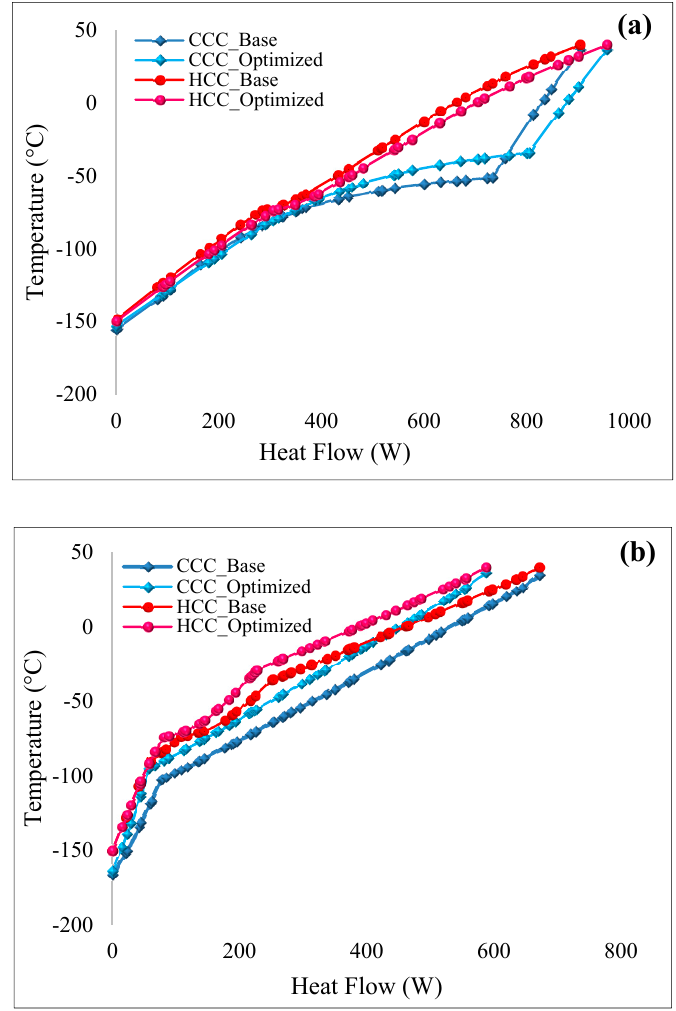
Figure 5. Temperature and heat-flow curves (THCCs) of base and optimized cases for CHX-01 of ( a ) SMR and ( b ) N 2 dual expander LNG processes.